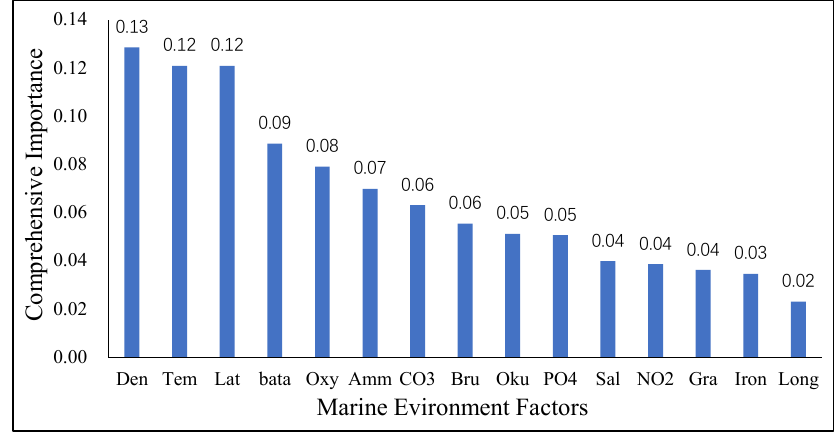
Figure 5. Comprehensive importance of the 15 environmental factors of the analyzed samples. Table 3. Comprehensive correlation indexes.